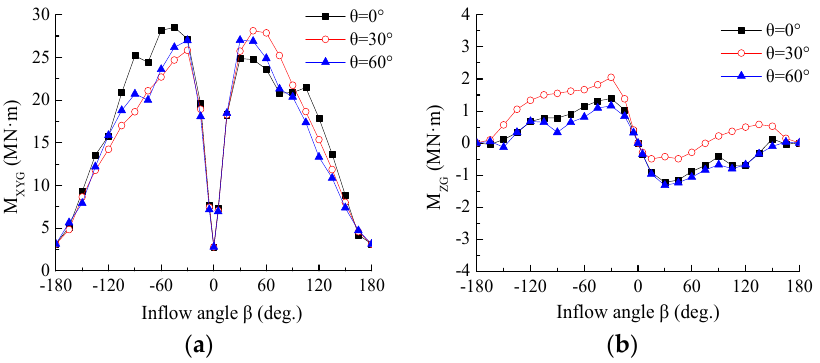
Figure 10. Average values of the foundation moments passed from the wind rotor: ( a ) The overturning moment passed from the wind rotor; ( b ) The torsional moment passed from the wind rotor.